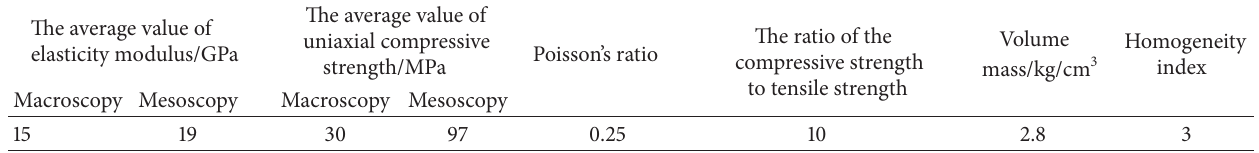
Table 1: The mechanical property of the sample of ore particle.